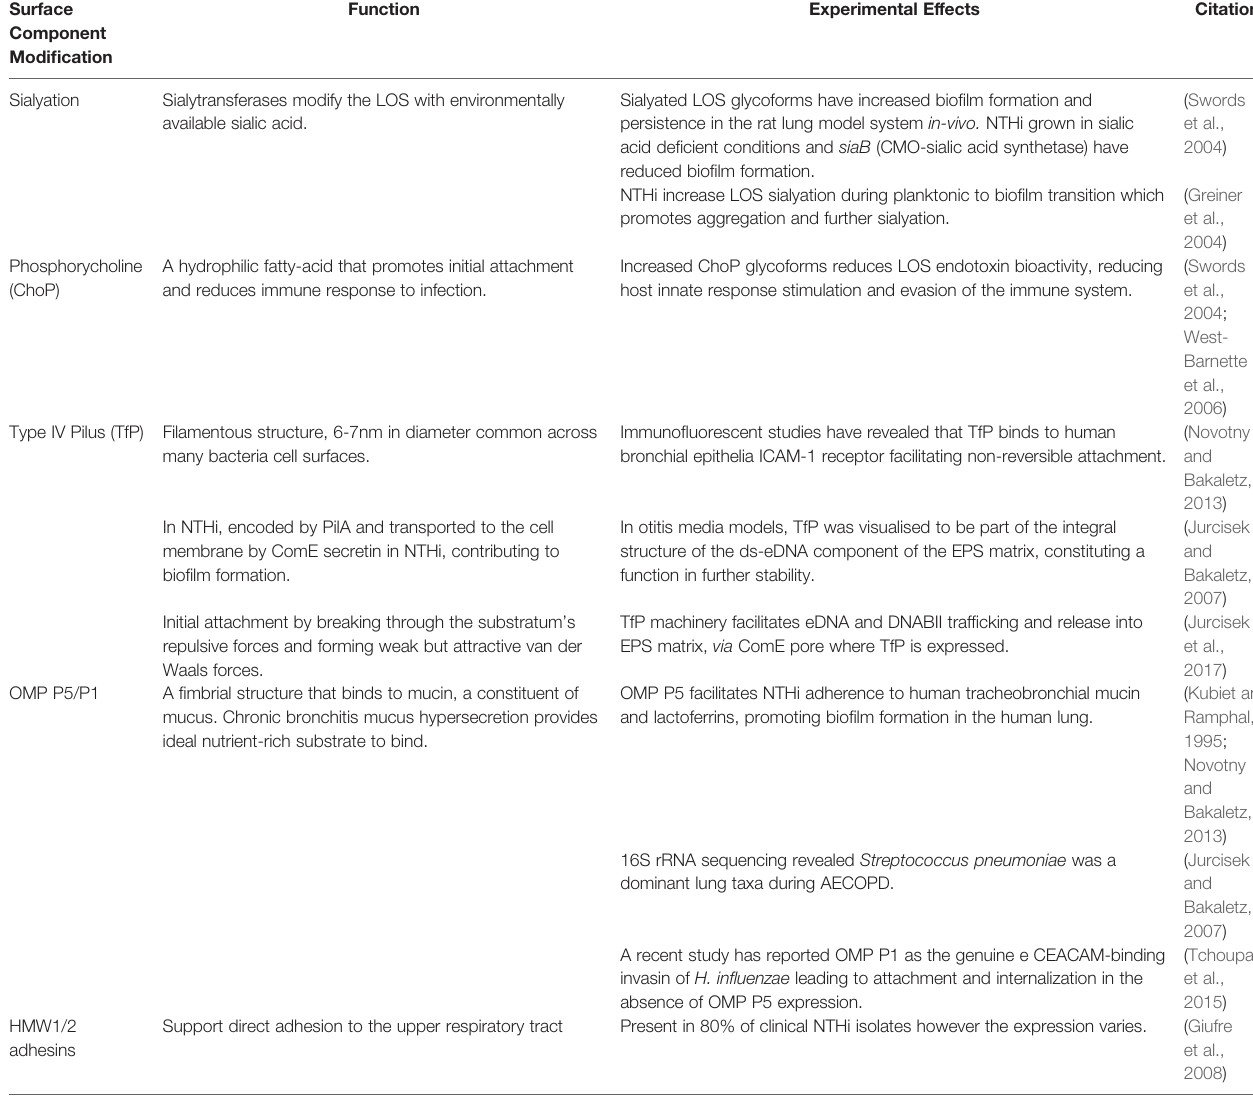
TABLE 2 | Summary of Key NTHi Surface Modi fi cations. Surface Component Modi fi cation